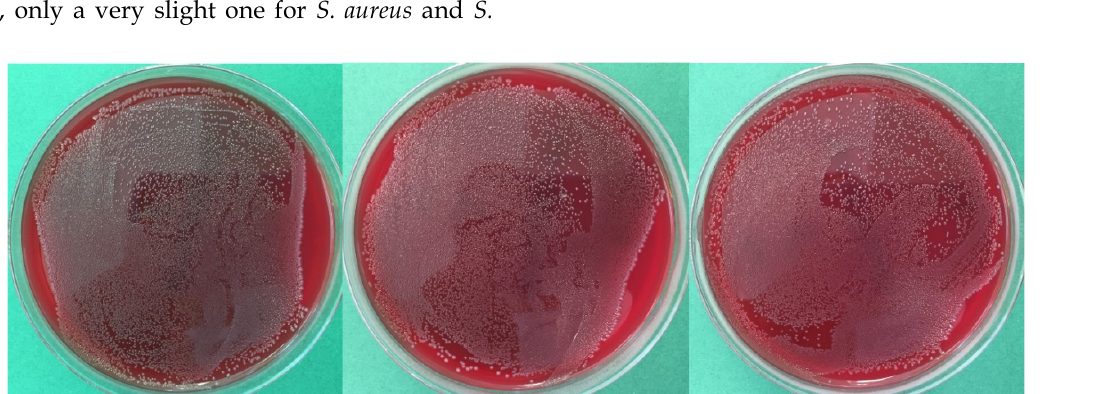
Figure 1 : Bacterial regrowth (methicilin-resistant S. aureus , Copal G+V) after 0, 60 and 240 minutes after sonication (representative plates)